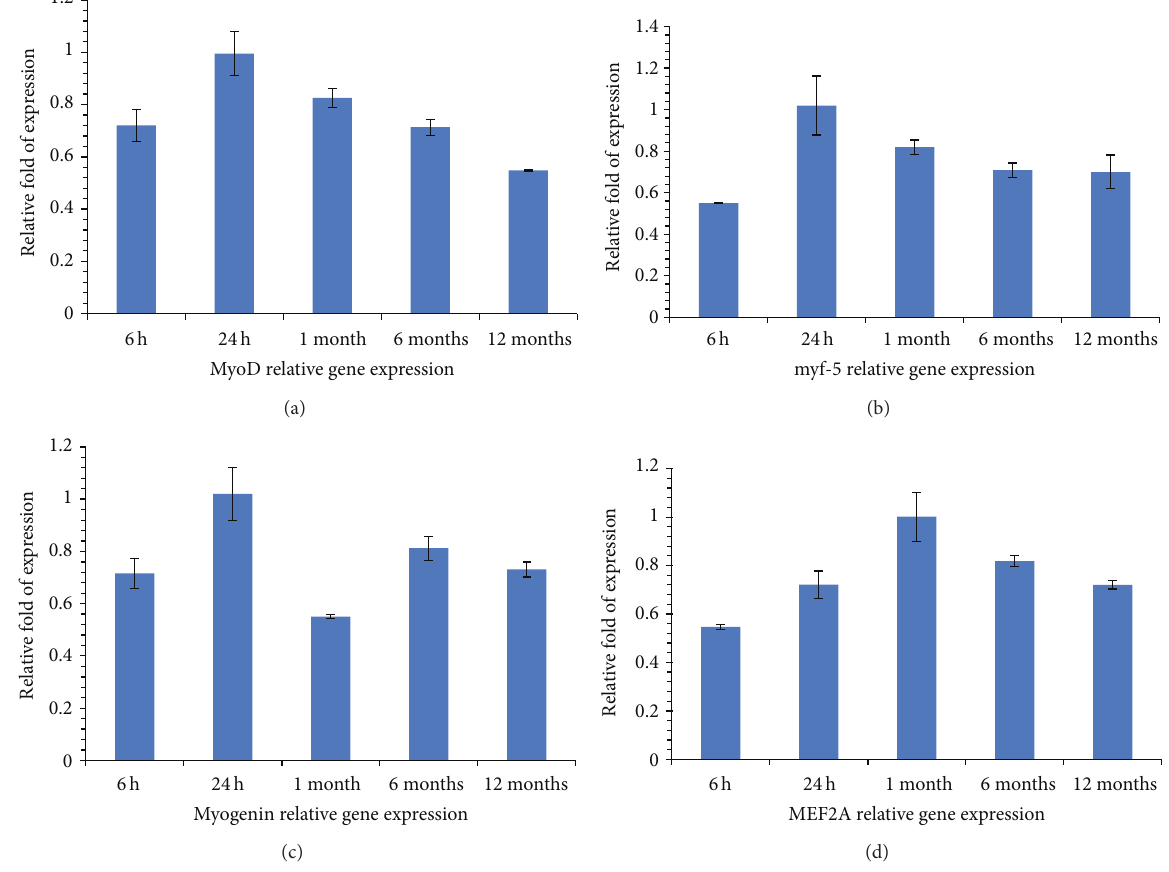
Figure 3: mRNA expression of four myogenic regulatory factors in Labeo rohita at 6h, 24 h, 1 month, 6 months, and 12 months of age (a) MyoD, (b) myf-5, (c) myogenin, and (d)